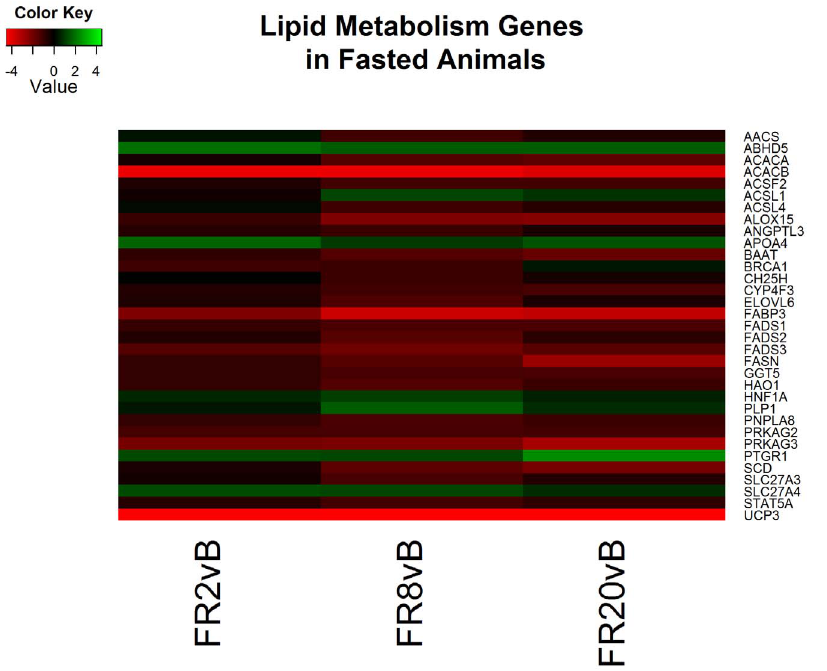
Figure 10. Heatmap of log2 fold changes of genes associated with carbohydrate metabolism in fasted (FS) animals at each resuscitation timepoint (2, 8, and 20 hours) relative to Baseline (B). Rows are differentially expressed genes (DEGs) following RNA sequencing. Columns denote the respective timepoints Baseline (B), 2 hours full resuscitation change from Baseline (FR2vB), 8 hours full resuscitation change from Baseline (FR8vB), and 20 hours full resuscitation change from Baseline (FR20vB). Green denotes increased mRNA expression with respect to Baseline whereas red denotes the opposite.